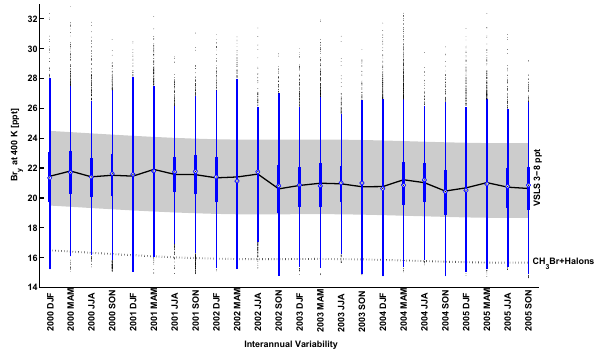
Fig. 10. Boxplots displaying the variability of the distributions of Br y arriving at 400K from all trajectories traversing the TTL from 2000 to 2005. The boxes illustrate the 25-th to 75-th percentiles, the whiskers 1.5 × the interquartile range and the crosses outliers. Yokouchi et al. (2005) boundary layer concentrations, a 30% BL component to the convective outflow, and washout at the CPT of 100% are used. The mean values for each year are given by the solid black line. The dashed line provides the Halons+CH 3 Br con- tribution (with the prescribed decreasing trend) (WMO, 2006, Ta- ble 8–5) and the grey shaded region the WMO recommendation for an additional VSLS contribution of 3–8ppt (WMO, 2006, Table 2–